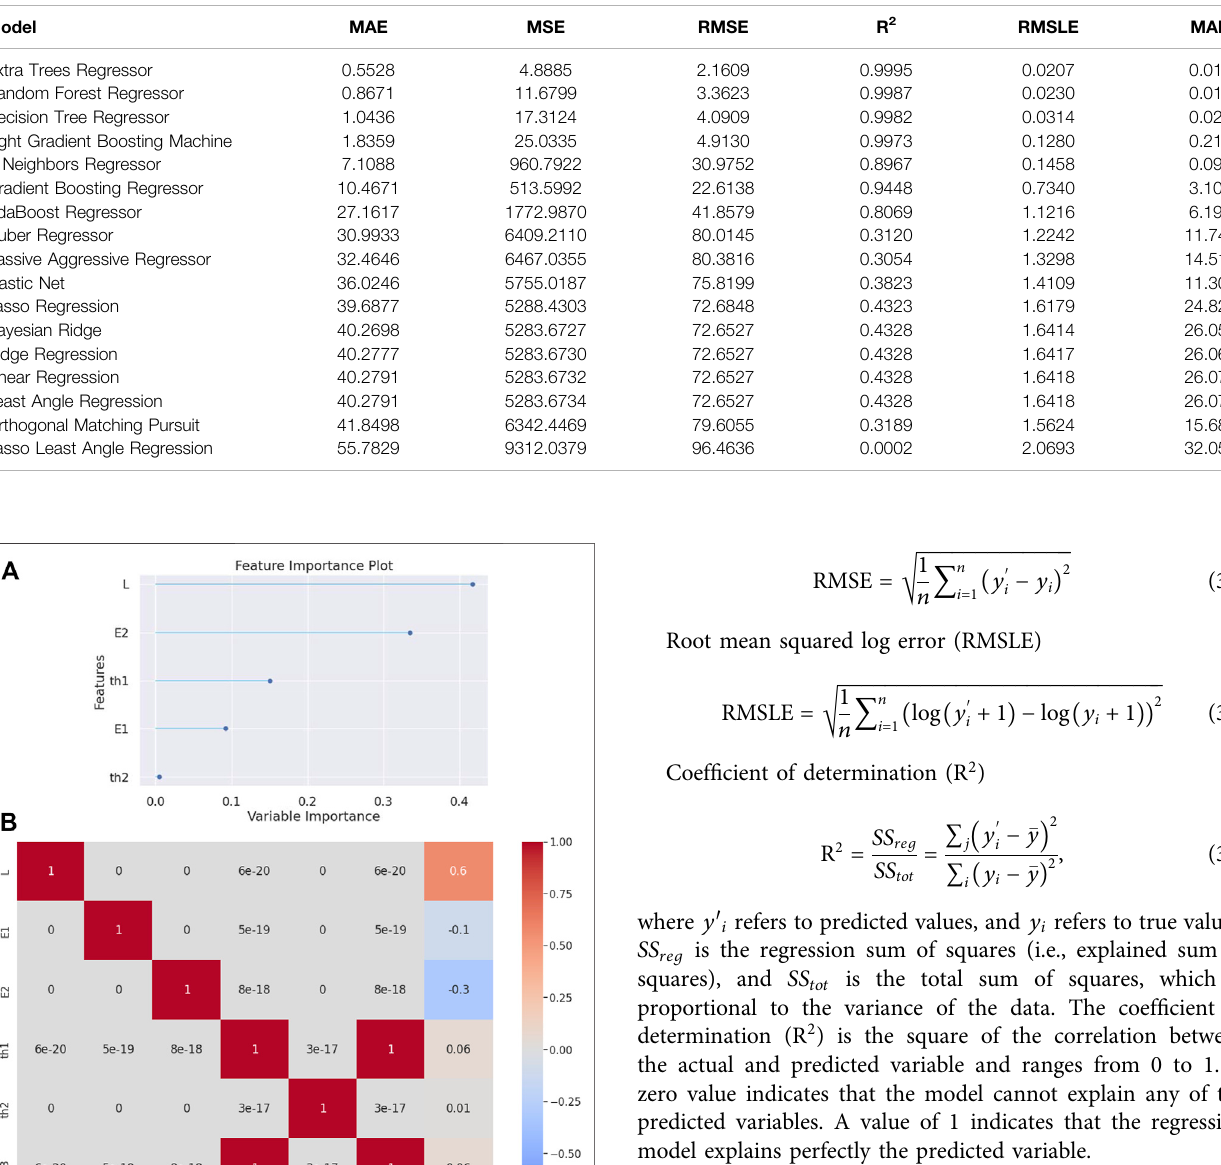
TABLE 5 | Evaluation metrics for the clamped-free beam.